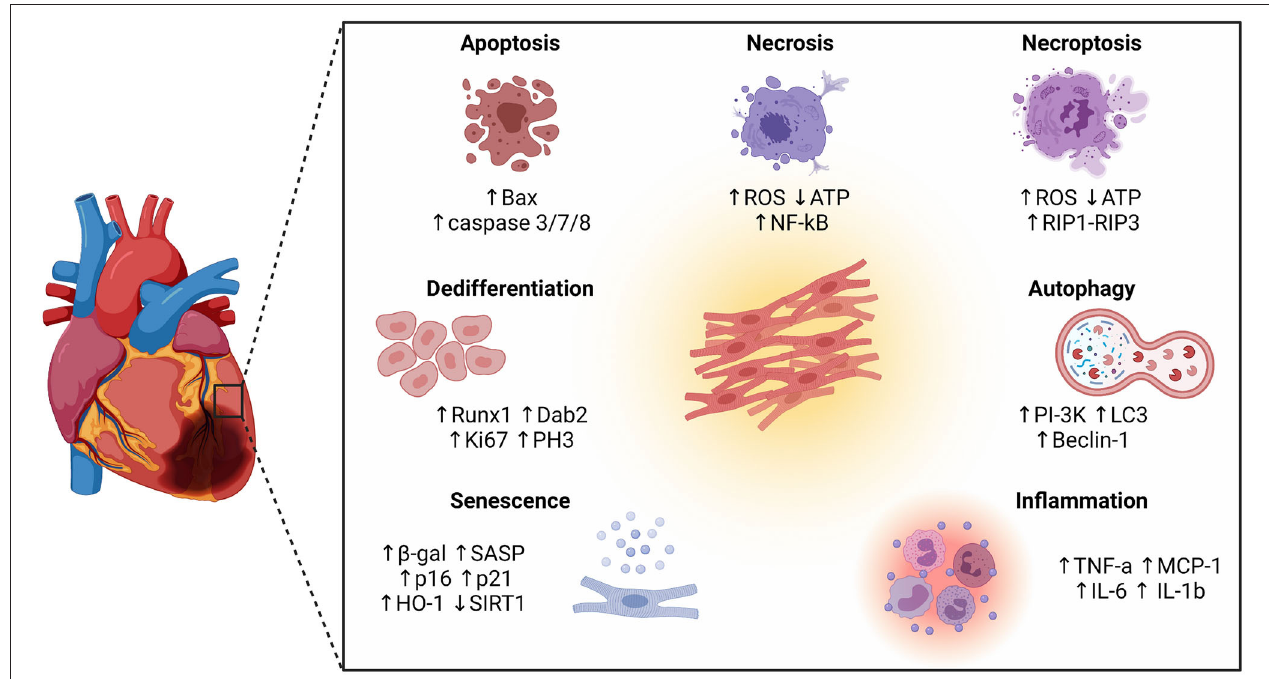
FIGURE 1 | Schematic representation of different cellular phenotypes and intracellular pathways involved in the pathophysiology of the infarcted heart. Besides different forms of cell death (apoptosis, necrosis, and necroptosis), other cellular phenotypes have emerged as key players in the ischemic myocardium, including autophagy, inflammation, senescence, and